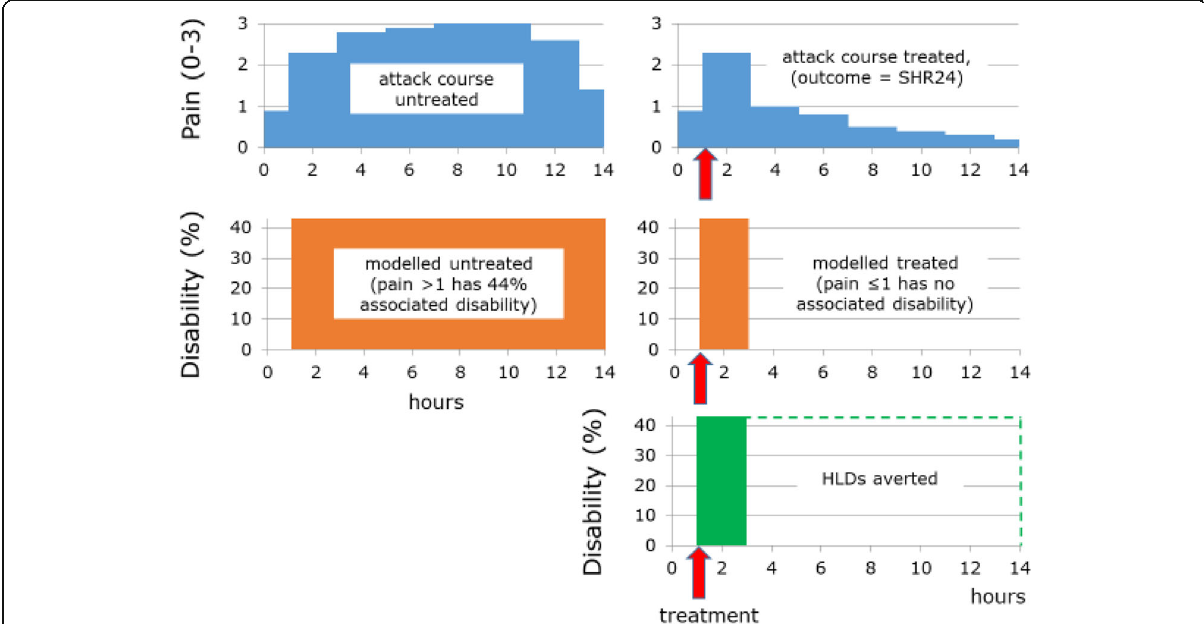
Fig. 1 Figurative depiction of how the outcome measure applies to acute therapy over the course of a single migraine attack in an individual (see text for